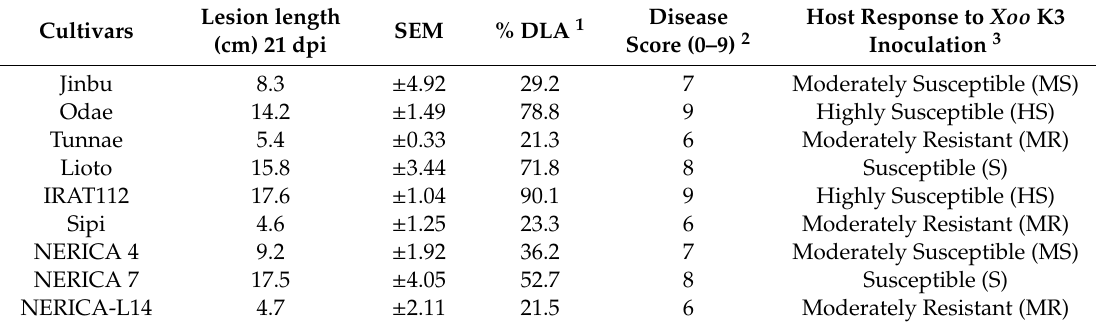
Table 4. Bacterial leaf blight disease scoring and host response at growth stage